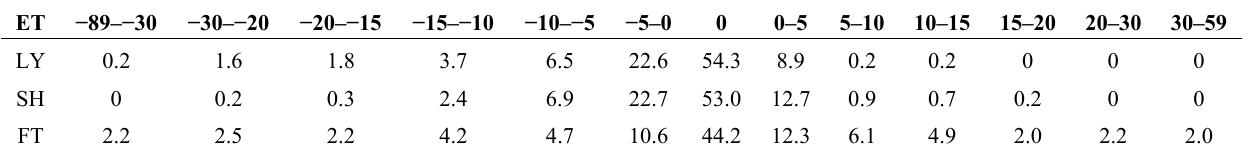
Table 11. Statistic distribution of ET variation in Scenario S1-S0 (area percentage, %). ET